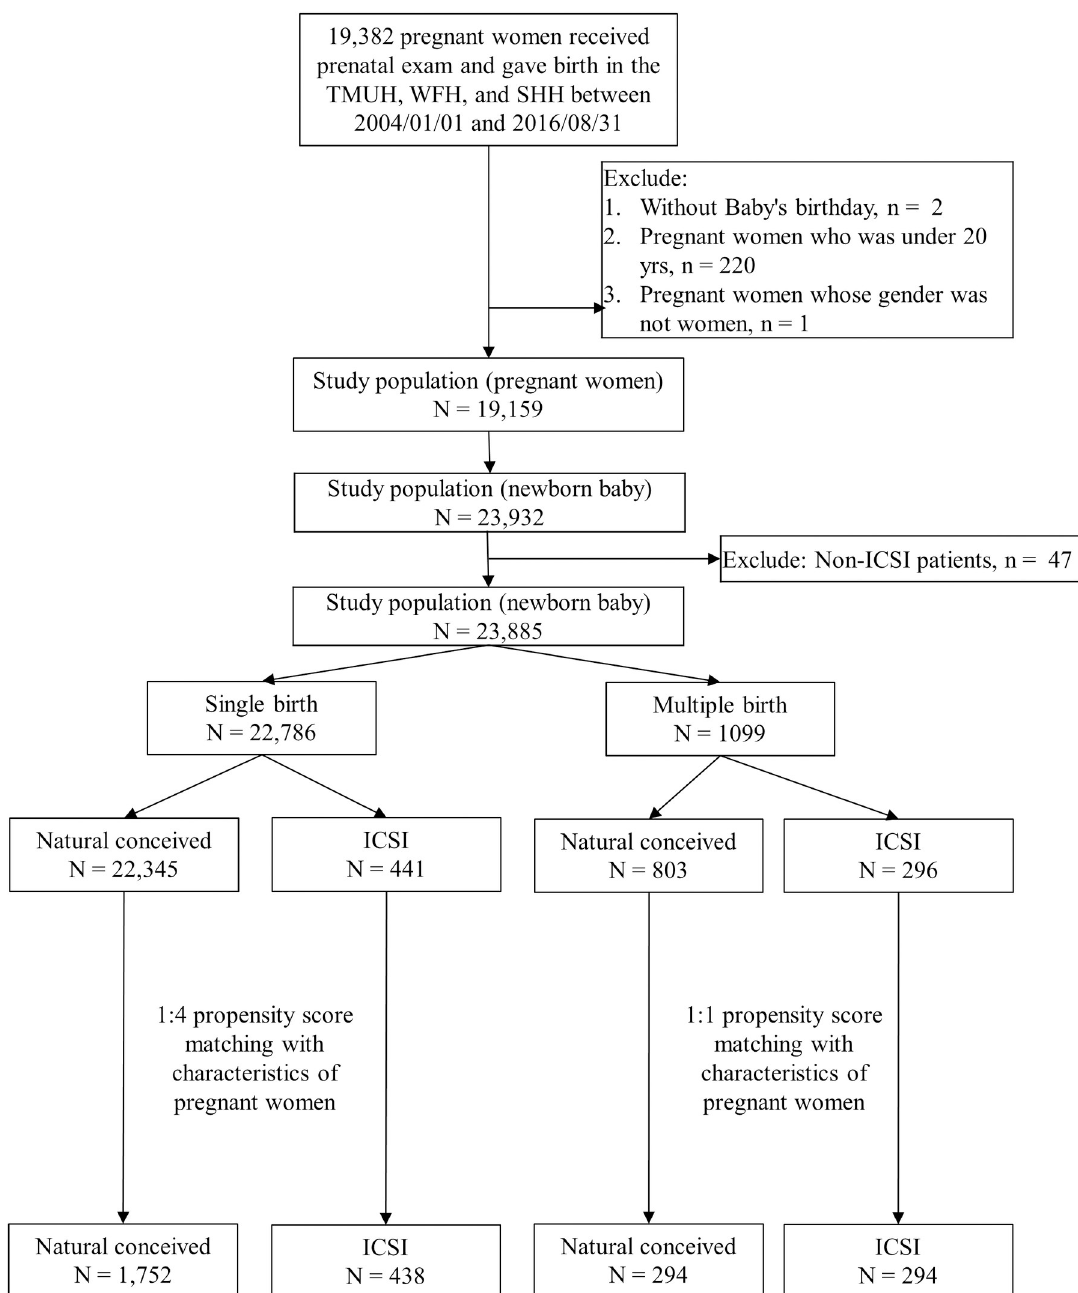
Fig 1. Inclusion and exclusion criteria flow